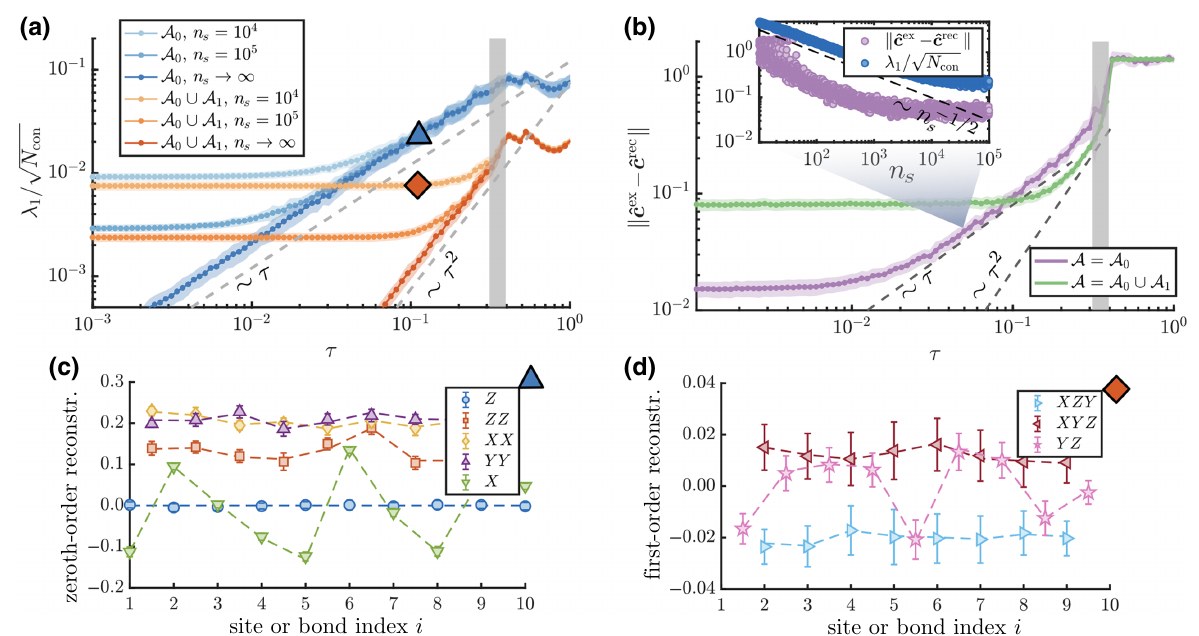
√ FIG. 2. Floquet Hamiltonian learning in DQS of the XXZ -Heisenberg model. (a) Scaling of λ 1 / N con with τ for a zeroth-order (blue) and first-order (orange) ansatz, and different measurement budgets n s . The plateau value at small τ can be predicted using Eq. (16). (b) Reconstruction error (cid:8)ˆ c ex − ˆ c rec (cid:8) versus τ for n s = 10 4 , for zeroth-order (purple) and first-order (green) ansätze. Here, ˆ c rec √ denotes the normalized reconstructed coefficient vector (similarly for ˆ c ex ). The scaling of λ 1 / N con is reflected in that of (cid:8)ˆ c ex − ˆ c rec (cid:8) , √ as predicted by Eq. (11). The inset shows the scalings of λ 1 / N con and (cid:8)ˆ c ex − ˆ c rec (cid:8) with n s for a fixed τ ≈ 0.05. In both (a) and (b) the vertical gray line denotes the value of τ at which Trotter errors proliferate. (c) Reconstructed Hamiltonian coefficients to zeroth order for τ = 0.098, showing perfect agreement with the exact values (dashed lines). The coefficients of terms that are absent from the Hamiltonian are reconstructed to be zero (blue data points). (d) Reconstructed Hamiltonian coefficients to first order for the same value of τ . Here the coefficients of the normalized ˆ c rec are shown, while in Appendix B we show how to extract their overall scale. The / y / y = 1 + δ x / y = 0.7 + δ z with δ x randomly distributed in [ − 0.15, 0.15], J z results are obtained for a system of N = 10 spins, with J x j j j j j ∈ [ − 0.25, 0.25], and B x ∈ [ − 0.75, 0.75]. We use 55 initial product states in random bases, each evolved to six different final with δ z j j times up to a total simulation time of 16. The error bars stem from measurement noise and from different initial states realizations. − 1 / 2 λ or the parameter distance, is proportional to n 1